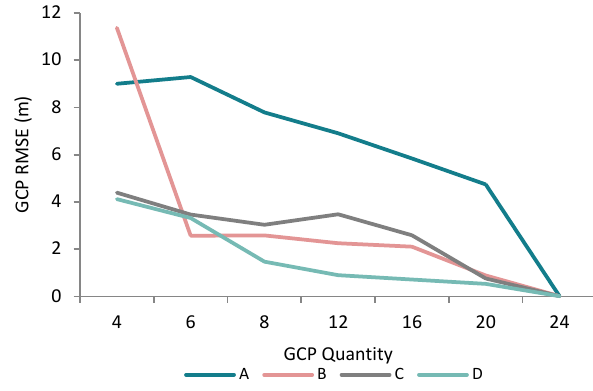
Figure 6. Total GCP RMSE magnitude of the four configuration class with respect to the GCP